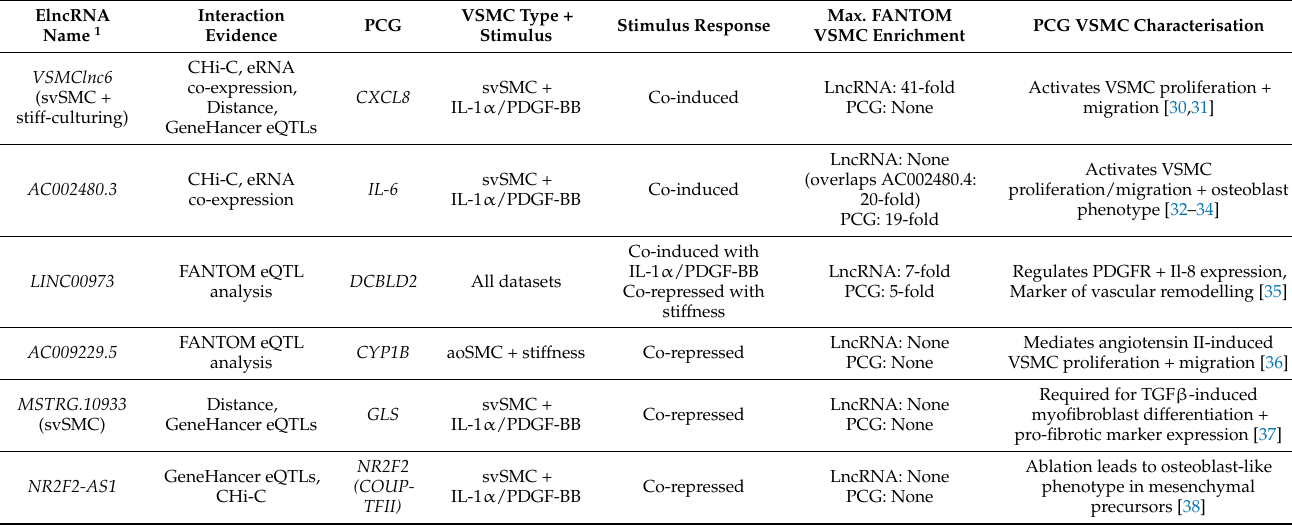
Table 1. Differentially expressed elncRNAs with predicted protein-coding gene (PCG) targets and links to VSMCs, proliferation and/or